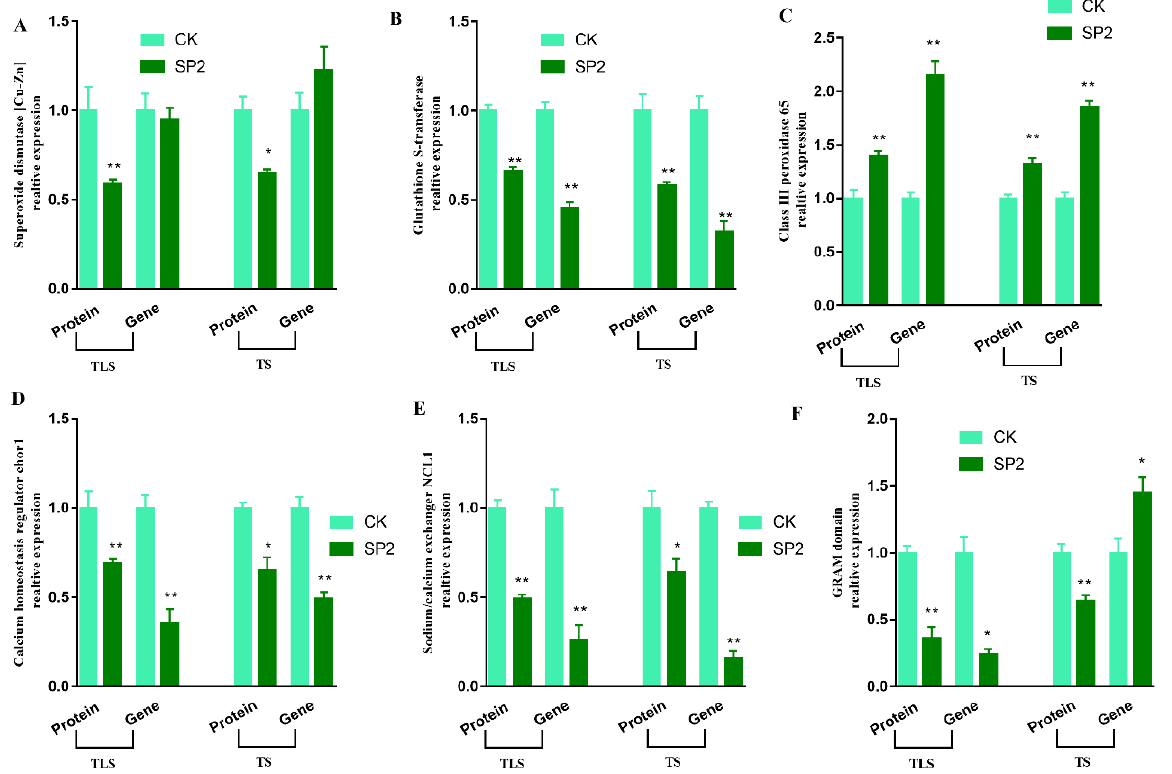
Figure 4. Comparison between protein abundance and mRNA level. The protein abundance in ground treatment and after spaceflight treatment leaves of offspring rice at three ‐ leaf stage (TLS) and tillering stage (TS) were assessed by ITRAQ ‐ based quantitative proteome analysis. Transcript abundance at two development stages (TLP, TS) was determined by quantitative RT ‐ PCR and normalized against the ACTIN gene. The cyan column represents the control group; the dark slate gray column represents treatment group. superoxide dismutase [Cu ‐ Zn] (A), glutathione transferase (B), sodium/calcium exchanger NCL1 (C), calcium homeostasis regulator chor1 (D), GRAM domain (E), Class III peroxidase 65 (F). The means and standard error values from three independent samples are shown (means ± SE; n = 3). * and ** indicate significant difference at p < 0.05 and <0.01 by Tukey’s test, respectively.